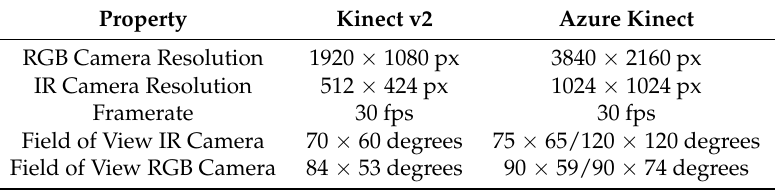
Figure 1. Both Kinect cameras used for this study with depicted camera coordinate systems. Table 1. Hardware comparison between Kinect v2 and Azure